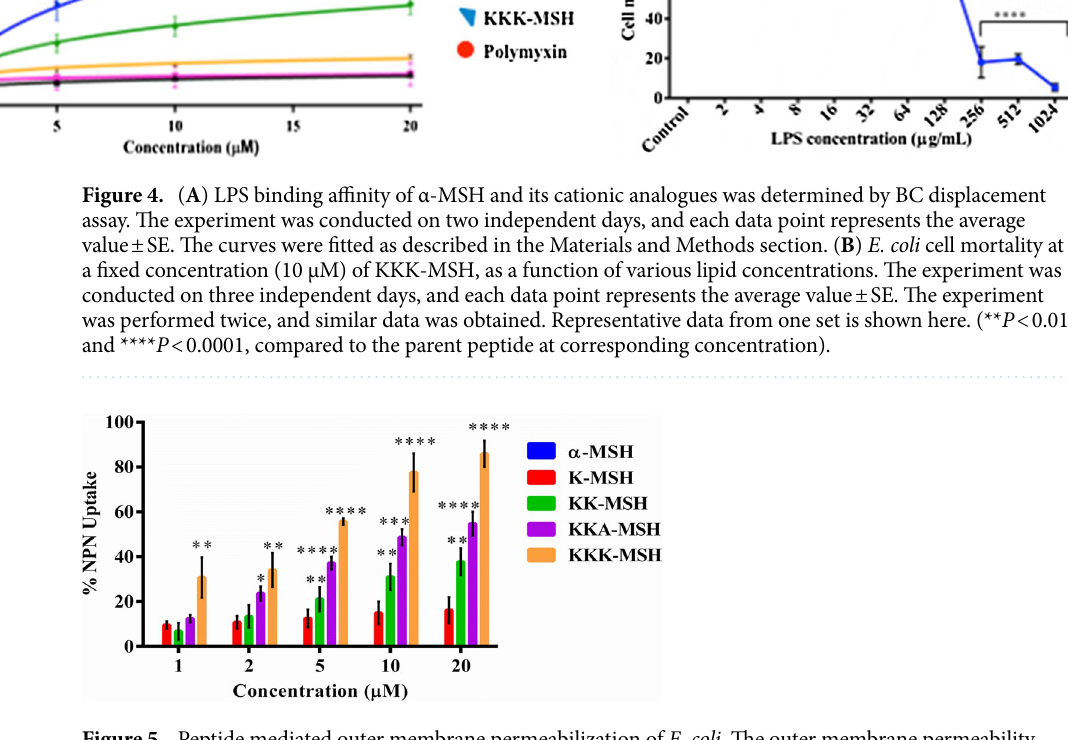
Figure 5. Peptide mediated outer membrane permeabilization of E. coli . The outer membrane permeability induced by α-MSH and its analogues was measured using the NPN (fluorescent probe) uptake assay. Data presented as average ± SE of the experiment repeated on three independent days. (** P < 0.01, *** P < 0.001, and **** P < 0.0001, compared to the parent peptide at corresponding